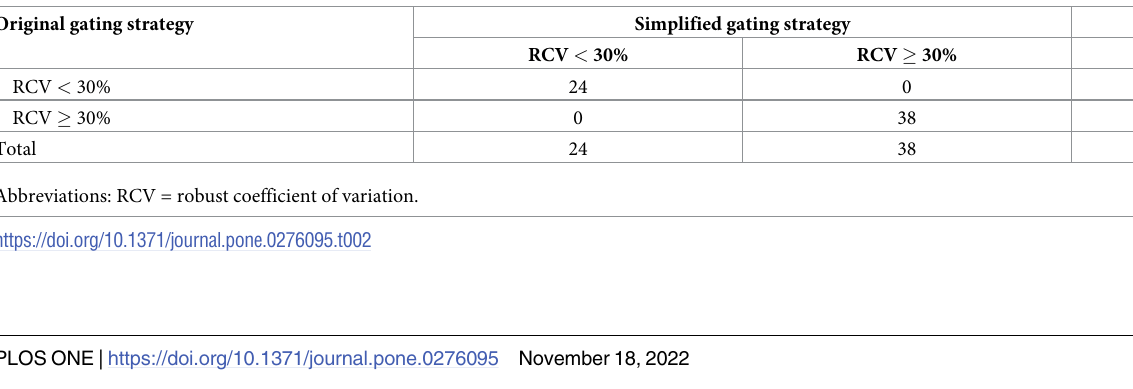
Table 2. Agreement of binary intra-individual robust coefficient of variation for peripheral blood neutrophil myeloperoxidase expression between simplified and original flow cytometric gating strategies (Cohen’s Kappa coefficient = 1.00). Original gating strategy